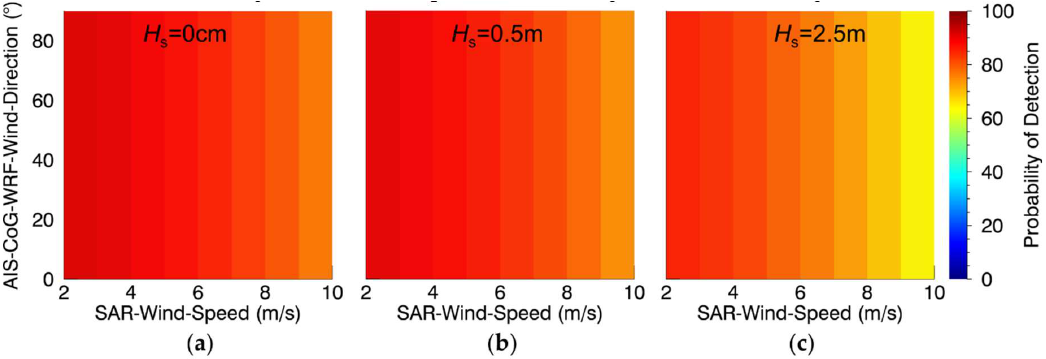
Figure 4. 2D detectability charts based on SAR-Wind-Speed, AIS-CoG-WRF-Wind-direction and from left to right SAR-Significant-Wave-Height with ( a ) 0 m, ( b ) 0.5 m, and ( c ) 2.5 m.